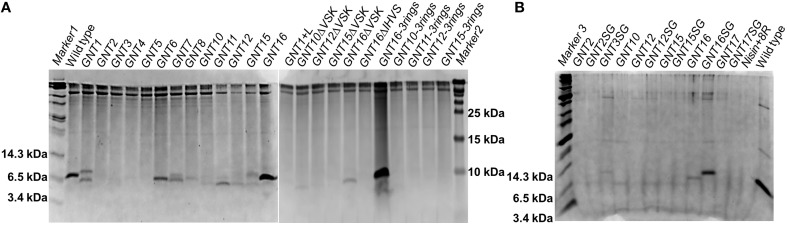
Coomassie-blue stained tricine SDS-PAGE gel. The fusion peptides were produced with NZ9000 (A) or with PA1001 (B). Each well contains TCA precipitated peptides from 600 μl supernatant. All the samples are prepeptides with the leader and his tag part still attached. The experiment was performed several times showing similar results.